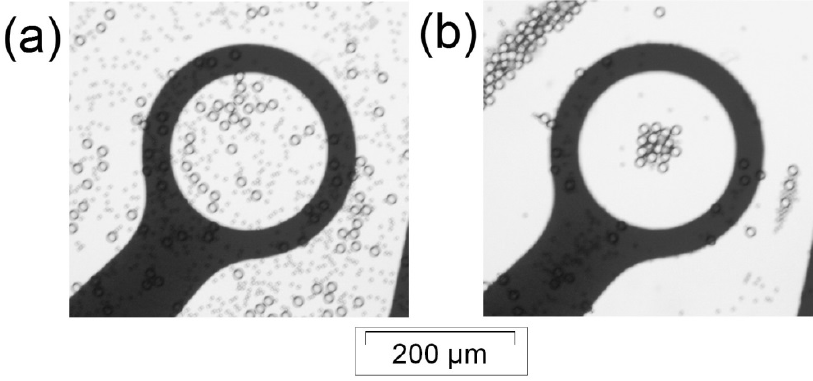
Figure 7. The separation of 5 and 15 μ m particles under DEP field. ( a ) A uniform mixture distribution of 5 and 15 μ m particles is shown. ( b ) After applying 12 kHz signal, the 5 μ m particles were attracted to the dot edge (p-DEP), while the 15 μ m particles were repelled to the dot center